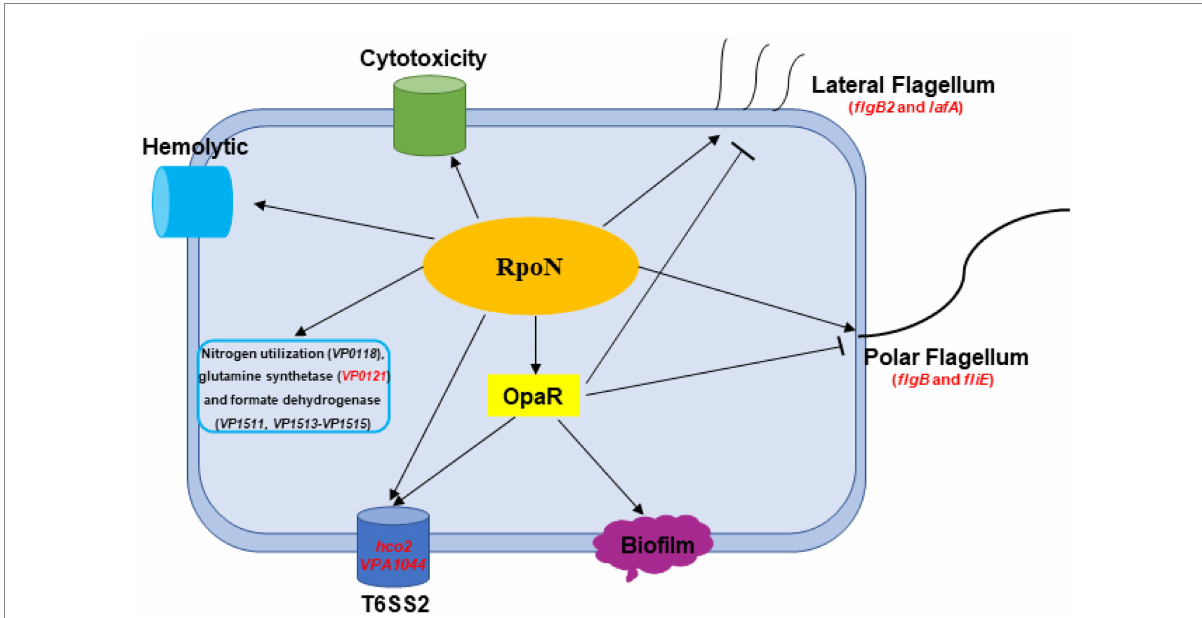
FIGURE 8 A schematic of the global regulatory networks of RpoN in V. parahaemolyticus . The RpoN directly binds to promoter regions of flgB , fliE , flgB2 , and lafA , and positively regulates swimming and swarming motility in V. parahaemolyticus . RpoN protein also directly bind to promoters of hcp2 and VPA1044 to regulate the expression of T6SS2. Furthermore, RpoN protein could directly regulate the expression of VP0121 to be responsible for nitrogen utilization. In addition, RpoN regulates the hemolytic activity, cytotoxicity, and motility in an OpaR-independent way, whereas RpoN regulates the T6SS2 and biofilm in an OpaR-dependent way in Vibrio parahaemolyticus . The red genes indicated the promoters directly bound by RpoN protein. The arrows indicate activation, while the bar-ended lines indicate